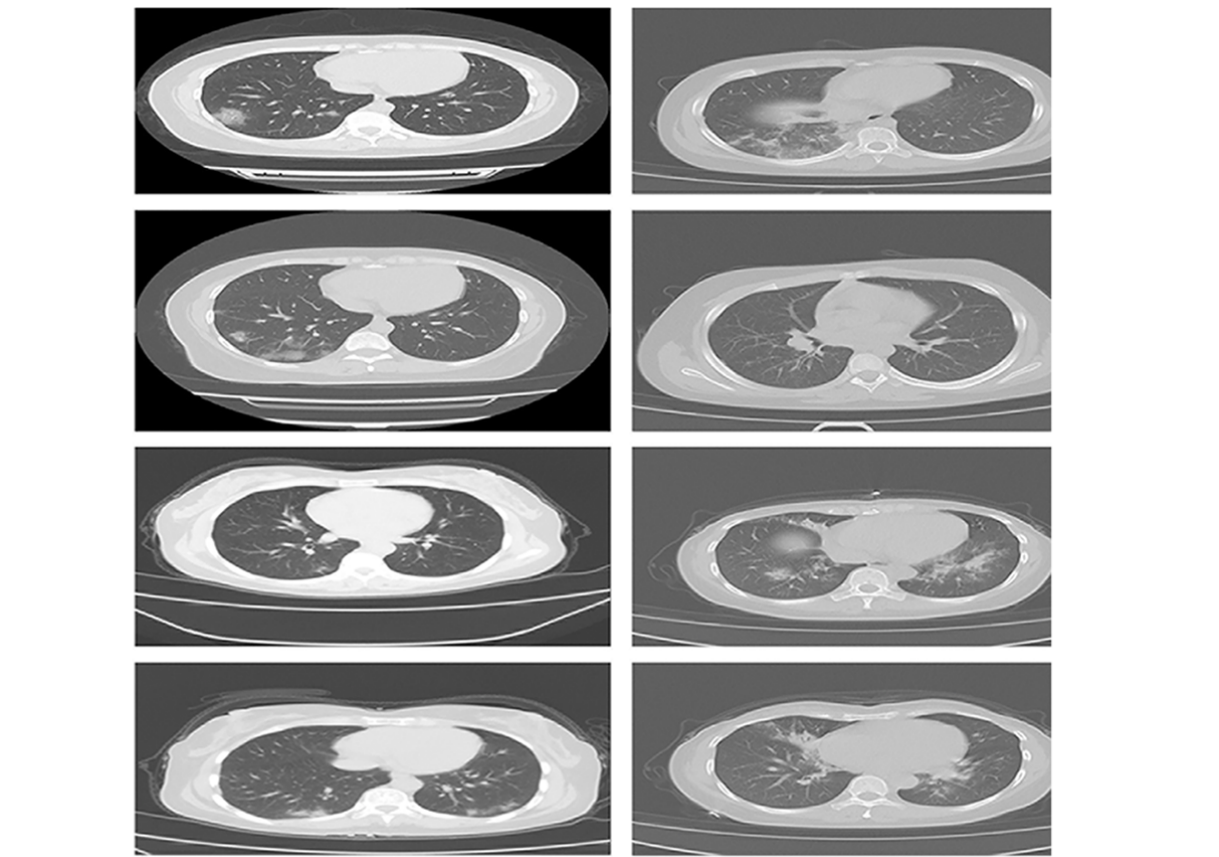
Figure 1. The images in the left panel are CT scans of four randomly selected confirmed COVID-19–positive patients. There are multiple patchy lesions, and the grinding glass shadows are distributed in the peripheral pulmonary field. The images in the right panel are CT scans of four randomly selected suspected patients who were confirmed to be COVID-19 negative. Their lesions are large, strip-like, and have uneven density. Pleural thickening near affected lung segments is also